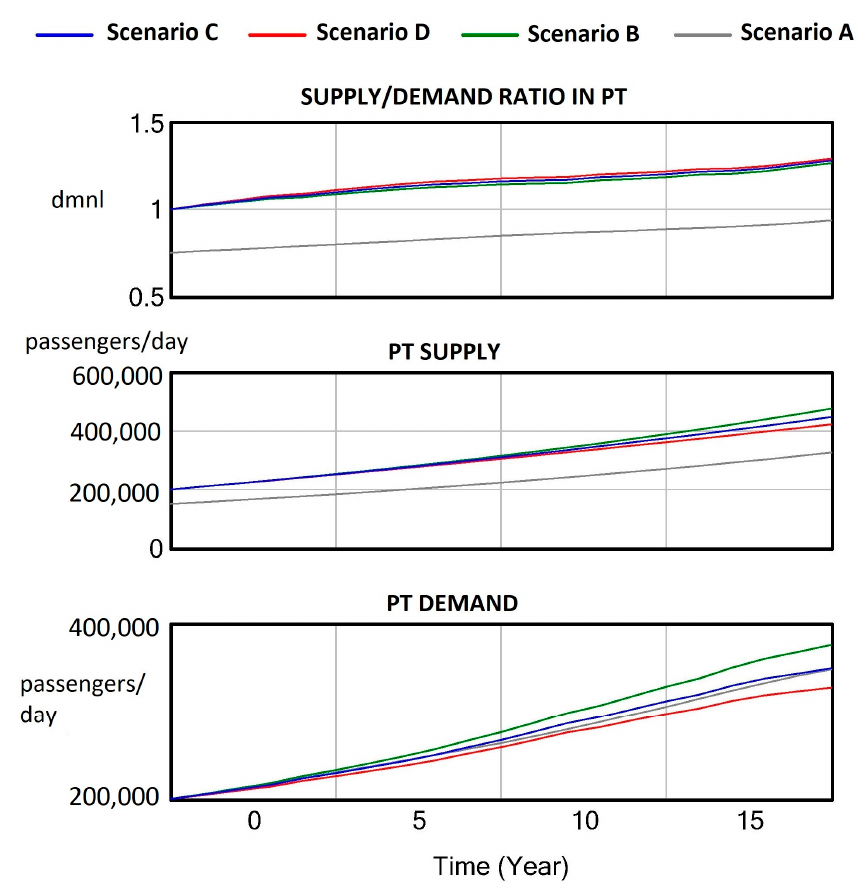
Figure 11. Trends in supply and demand in